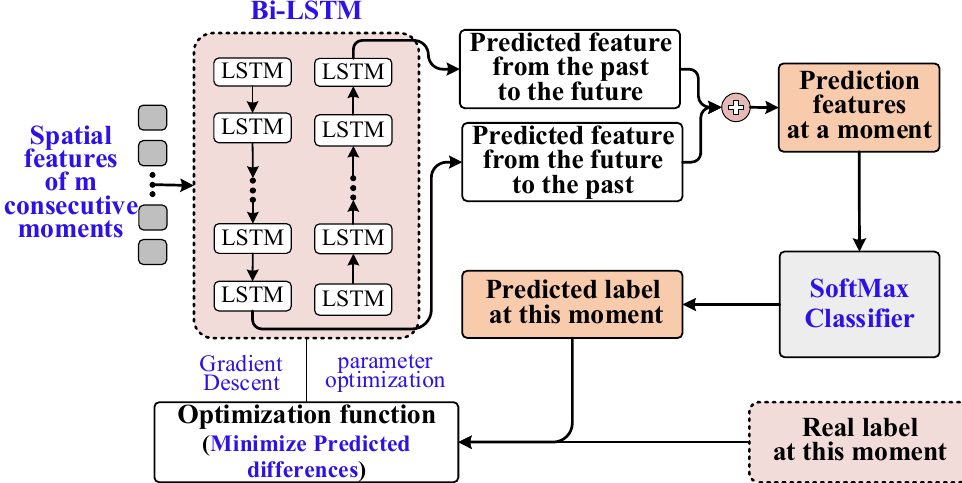
Figure 3. Bi-LSTM update process.